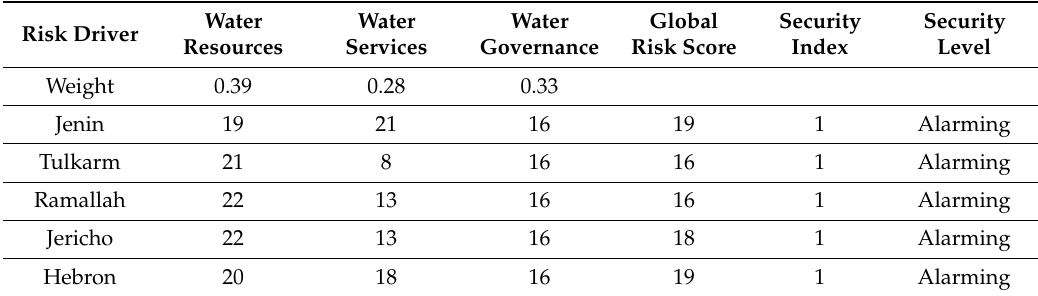
Figure 6. Experts’ opinion concerning the importance of the categories of indicators C1: water resources, C2: water services and C3: water governance. Table 25. Global water security score and security index (determined from Tables 4, 14, 20 and Table 24. Determination of weights of water resources (WR), water services (WS) and water governance (WG) indicators.